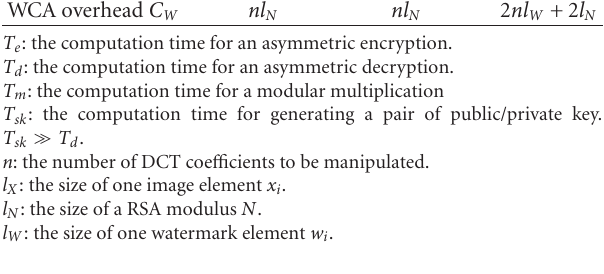
Table 2: Example performance